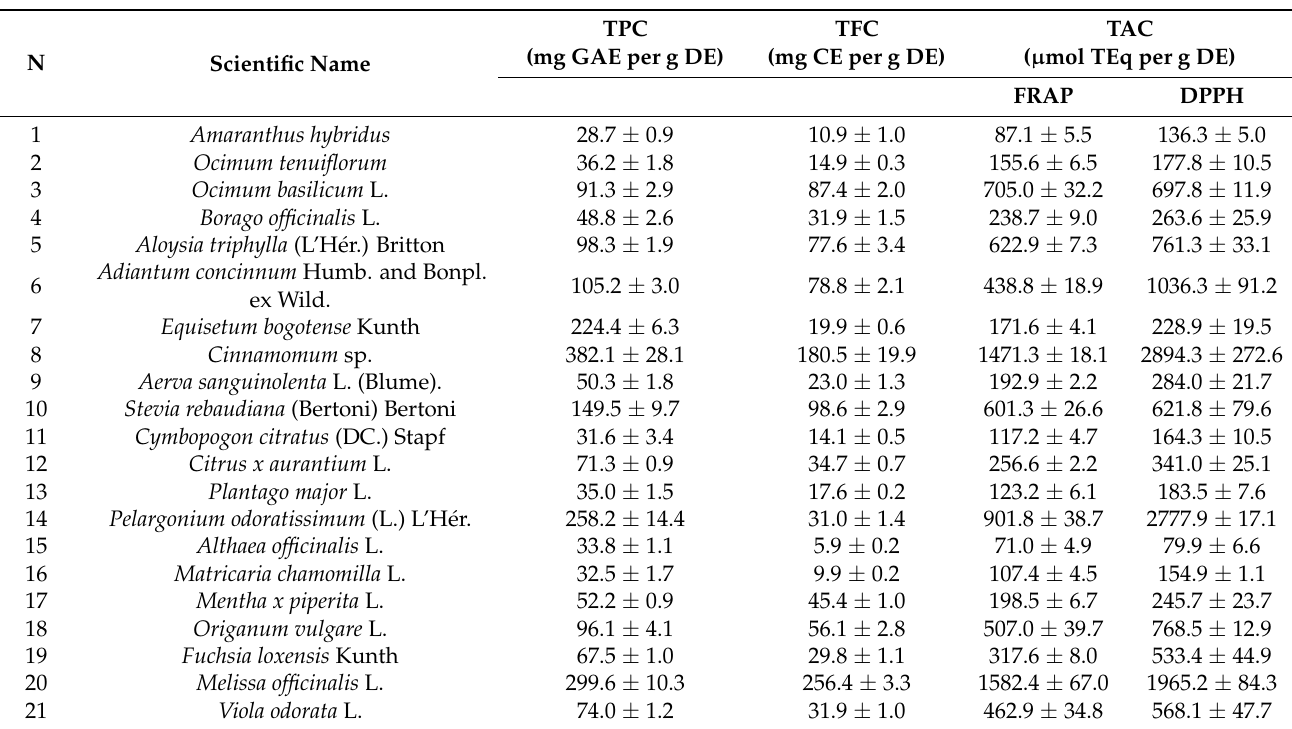
Table 1. Total phenolic content, total flavonoid content, and total antioxidant capacity of 21 crude plant extracts used in the herbal infusion